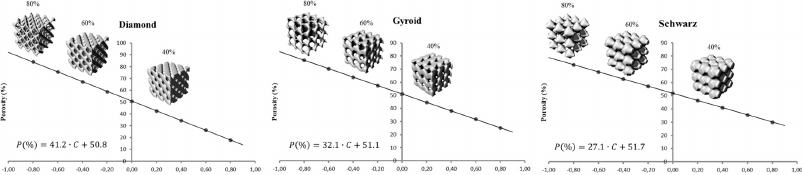
Figure 1. Correlation between percentage of porosity and C value for Diamond, Gyroid and Schwarz-based unit cells